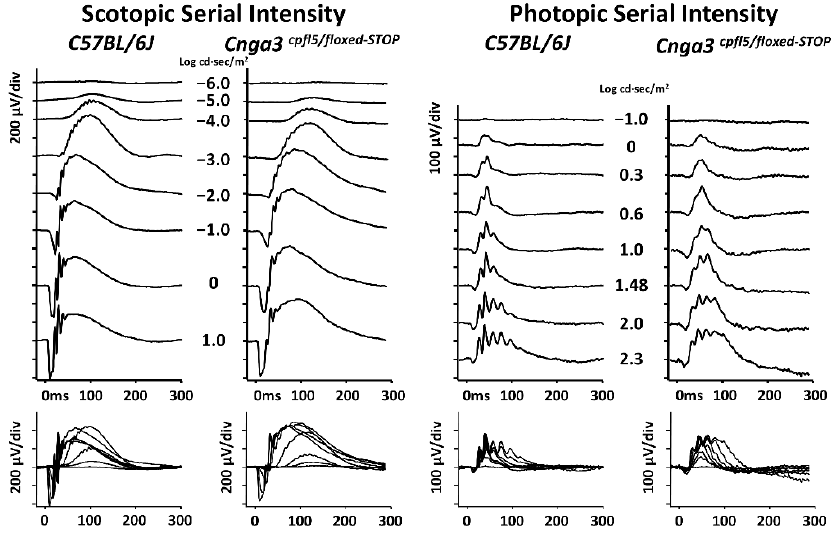
Figure 7. Electroretinography (ERG) of compound heterozygous Cnga3 cpfl5/floxed-STOP mice. The scotopic and photopic serial intensity ERG responses from these compound heterozygous mice showed relatively normal ERG responses as compared to C57BL/6J mice at the same age (postnatal day 31, P31).